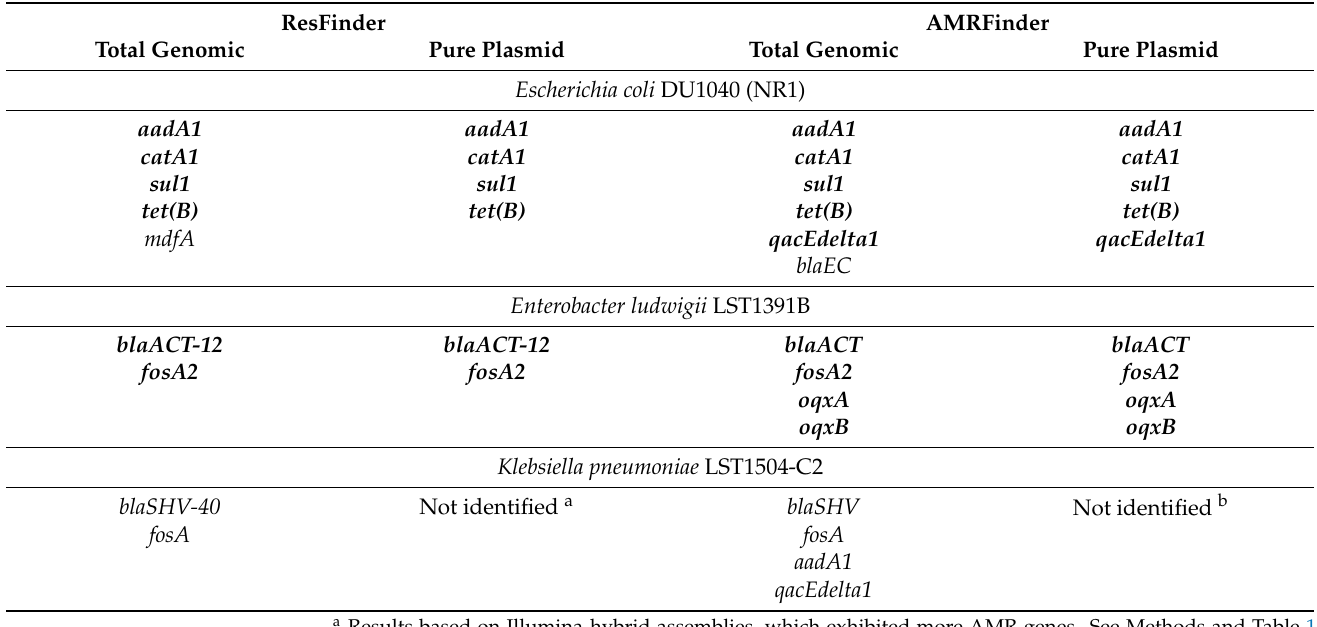
Table 2. Antimicrobial resistance (AMR) genes detected in the total genomic DNA vs. in pure plasmid DNA